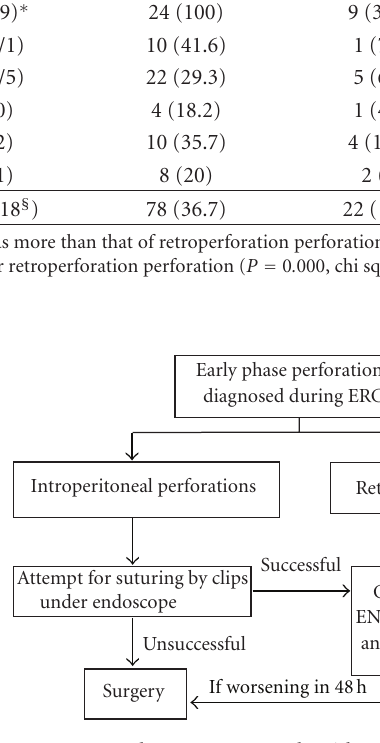
Figure 5: Early management algorithm of ERCP-related perfora-